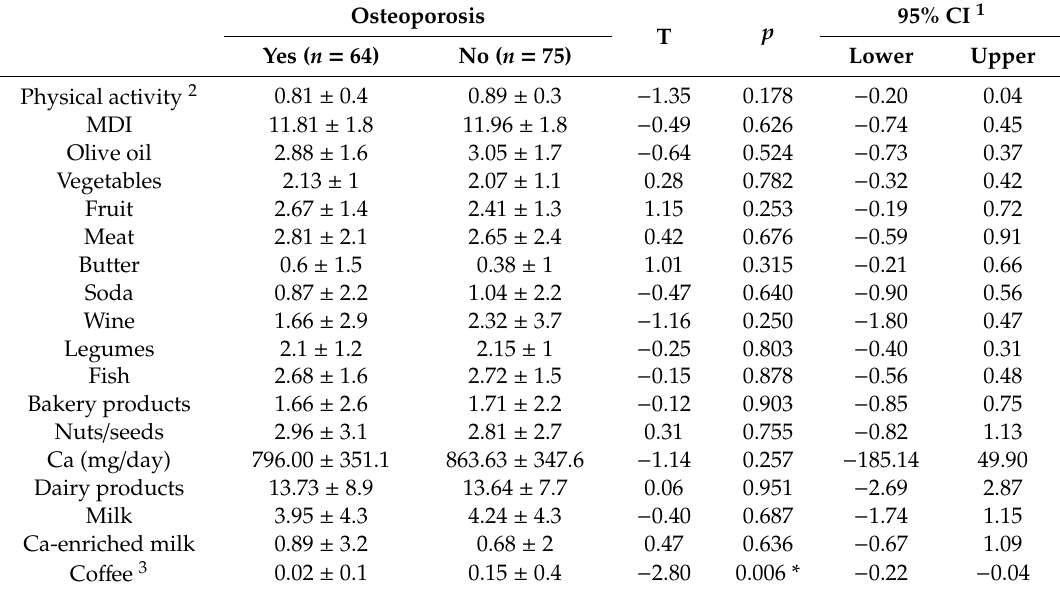
Table 2. Mediterranean diet adherence, intake of specific foods (portions / day) and physical activity data in participating women by osteoporosis status (given in mean